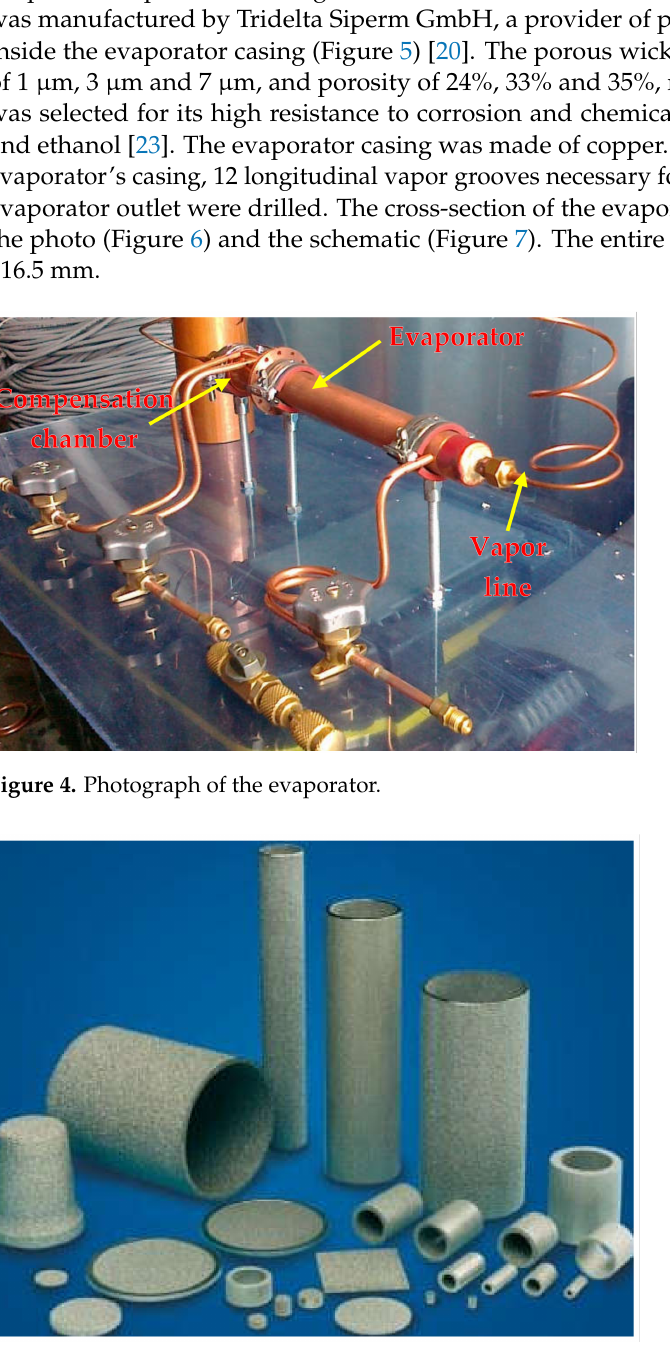
Figure 5. Examples of the wick manufactured by Tridelta Siperm GmbH